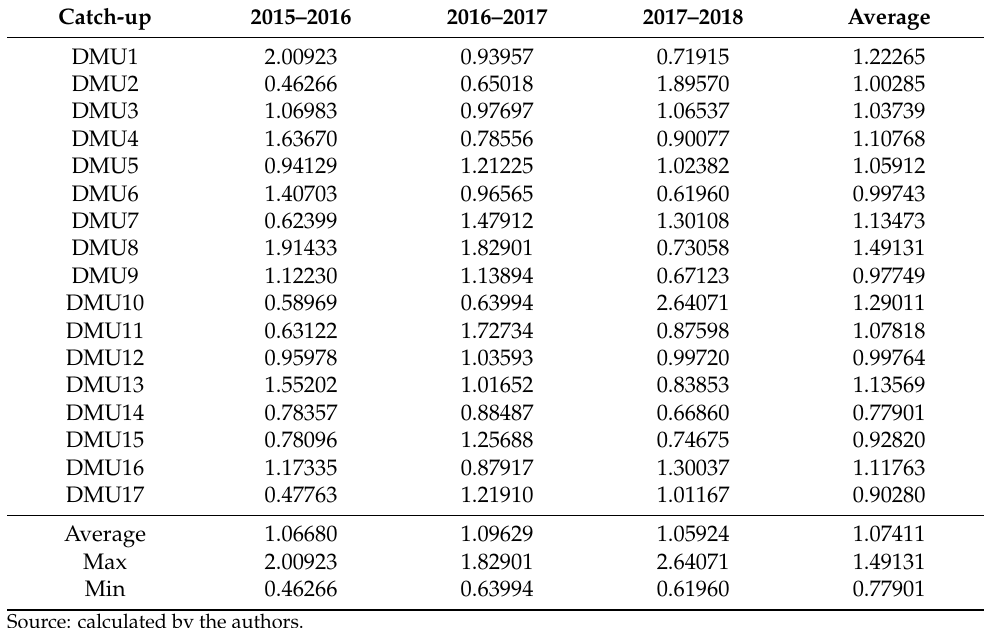
Table 6. Catch-up index (efficiency change).